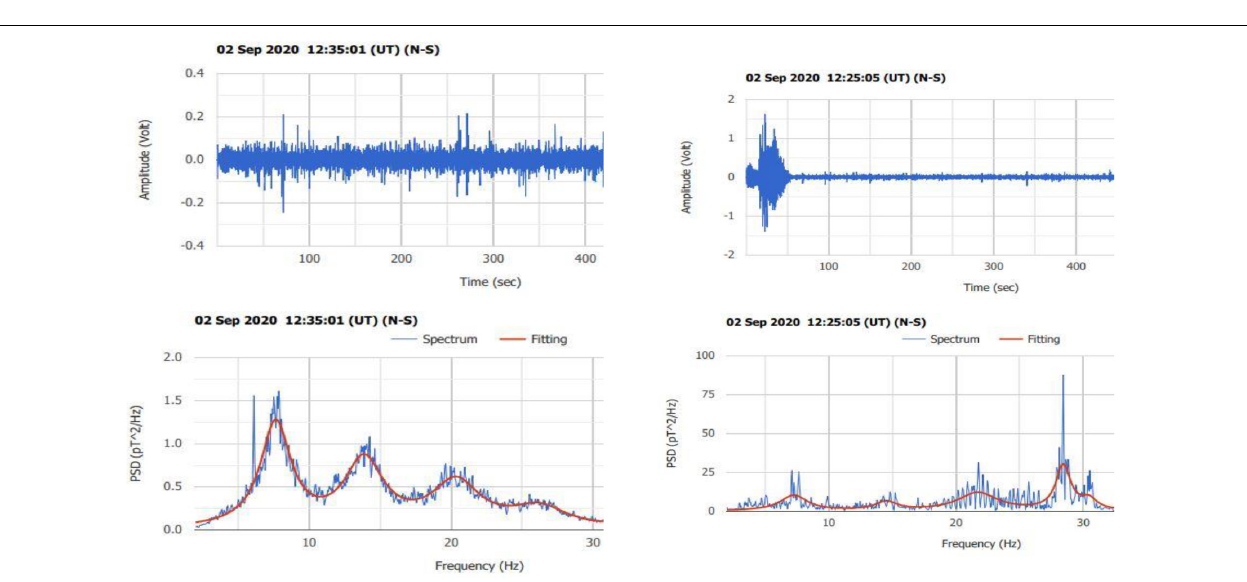
FIGURE 10 | Right panel : the effect of shooting with a hunting rifle. Left panel : undisturbed spectrum 10 min after shooting.